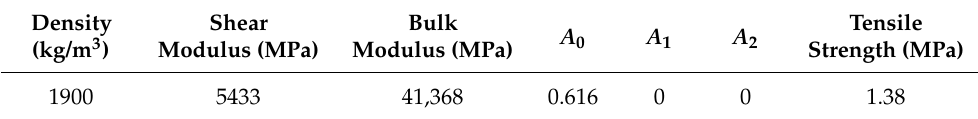
Table 2. CMU block material model parameters.